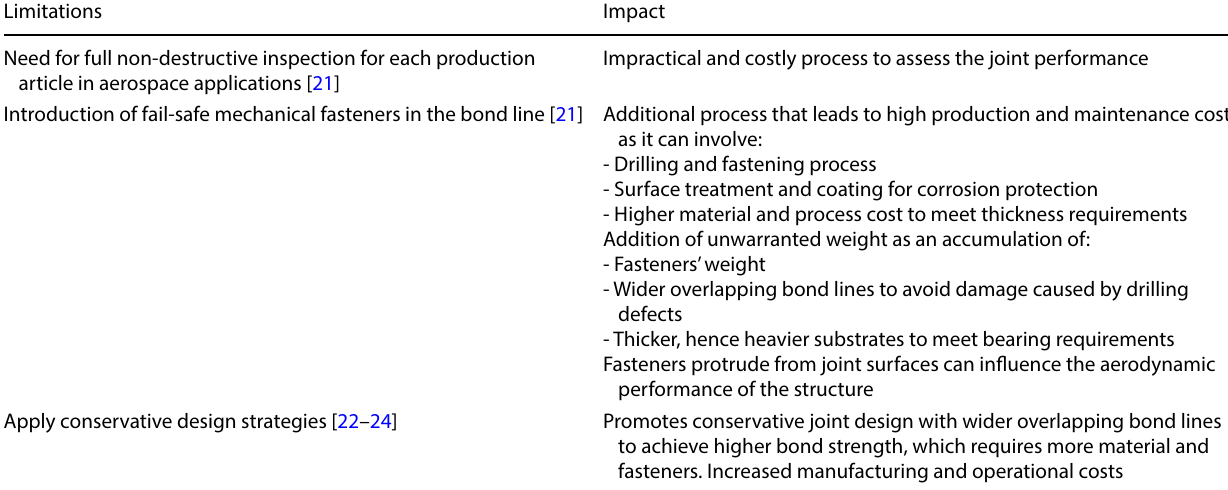
Fig. 4 The main three modes of adhesive bond failure: a Adhesive or interface failure. b Cohesive failure. c Substrate or adherend